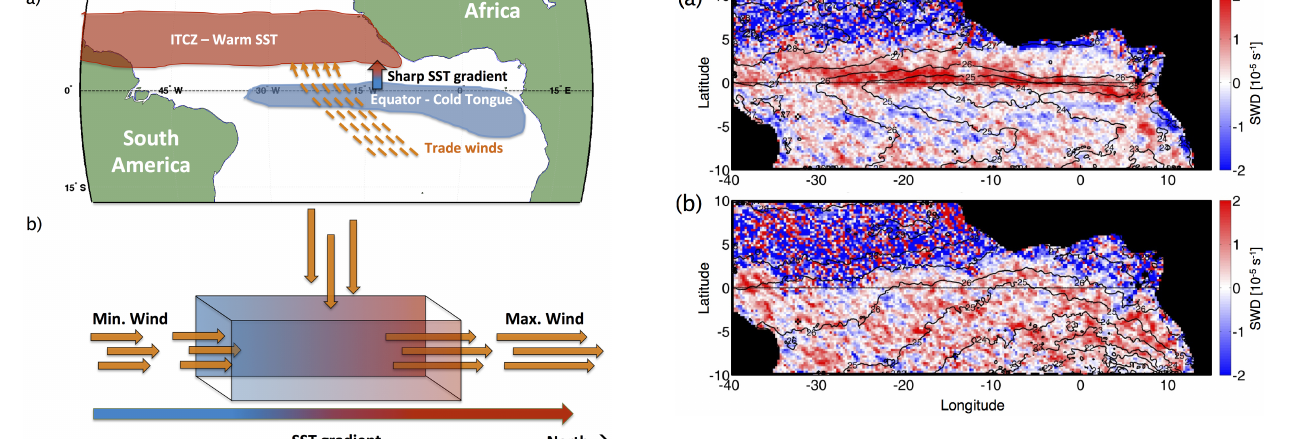
Figure 2. Tropical Atlantic monthly maps of mean surface wind divergence (in units of 10 − 5 s − 1 , color) and sea-surface tempera- ture ( ◦ C, black contours) for (a) July and (b) October 2007, using QuikSCAT-SeaWinds and